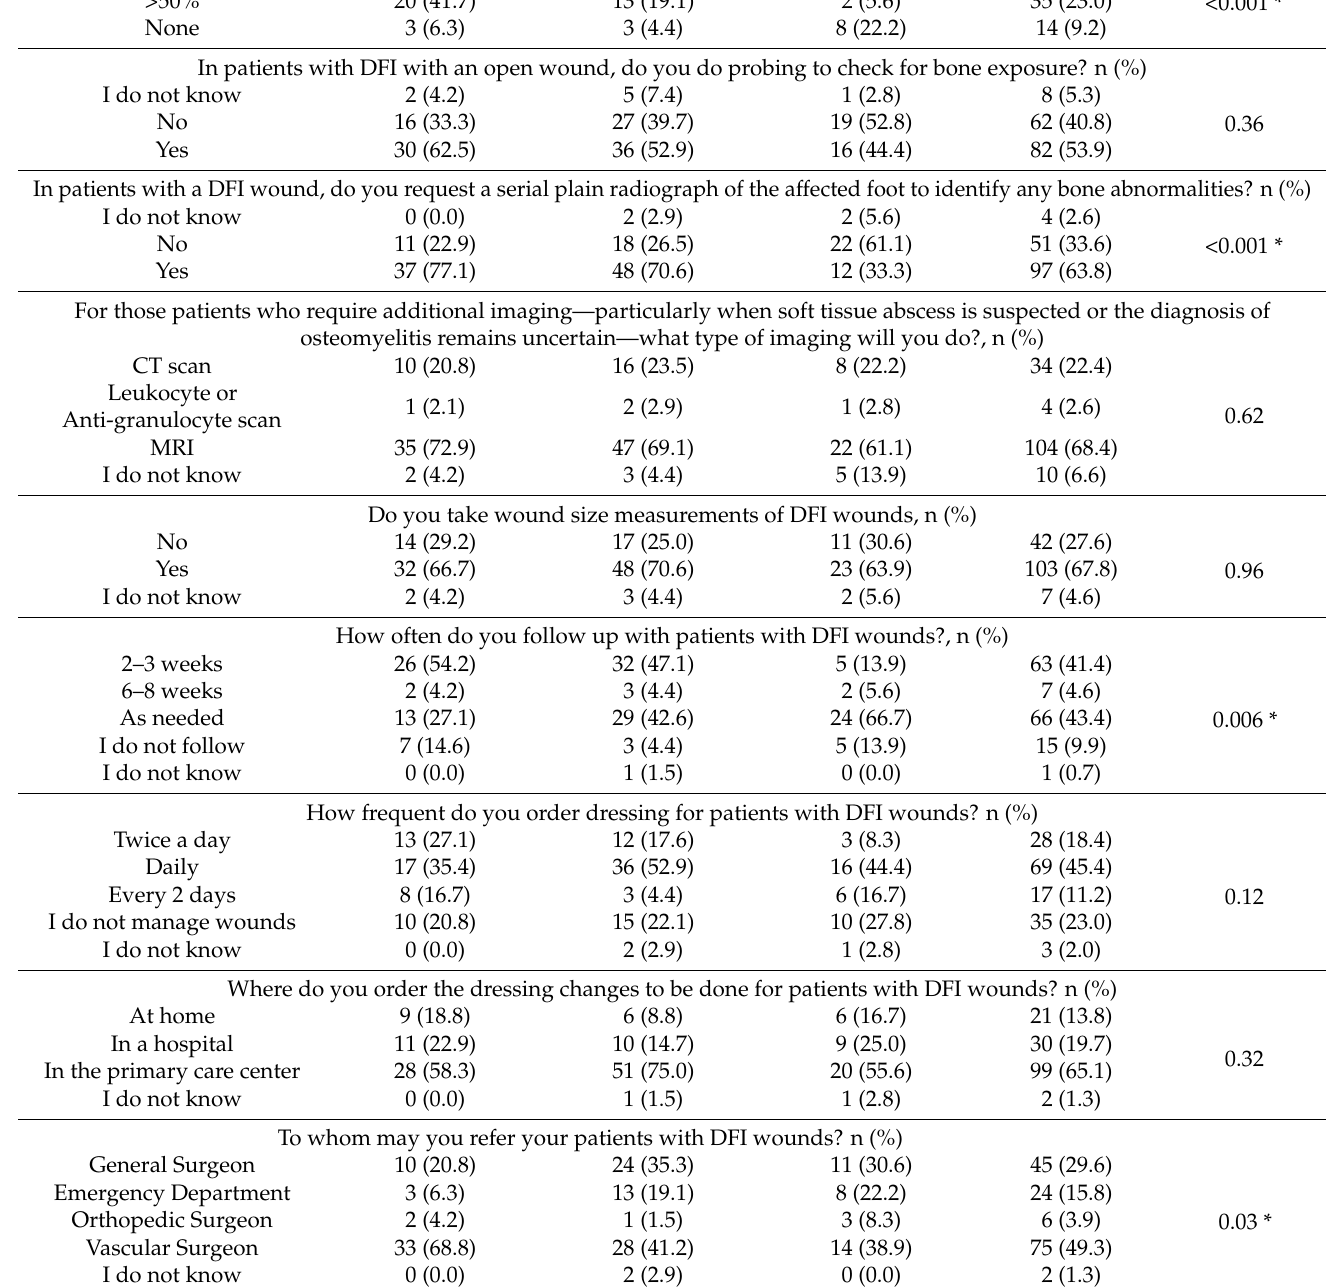
Table 4. Participants’ collective understanding and attitudes toward diagnosis and management of diabetic foot infections in patients with diabetic foot. General Family Medicine Family Medicine Practitioners Residents Consultants (n = 36) (n = 68) (n = 48)